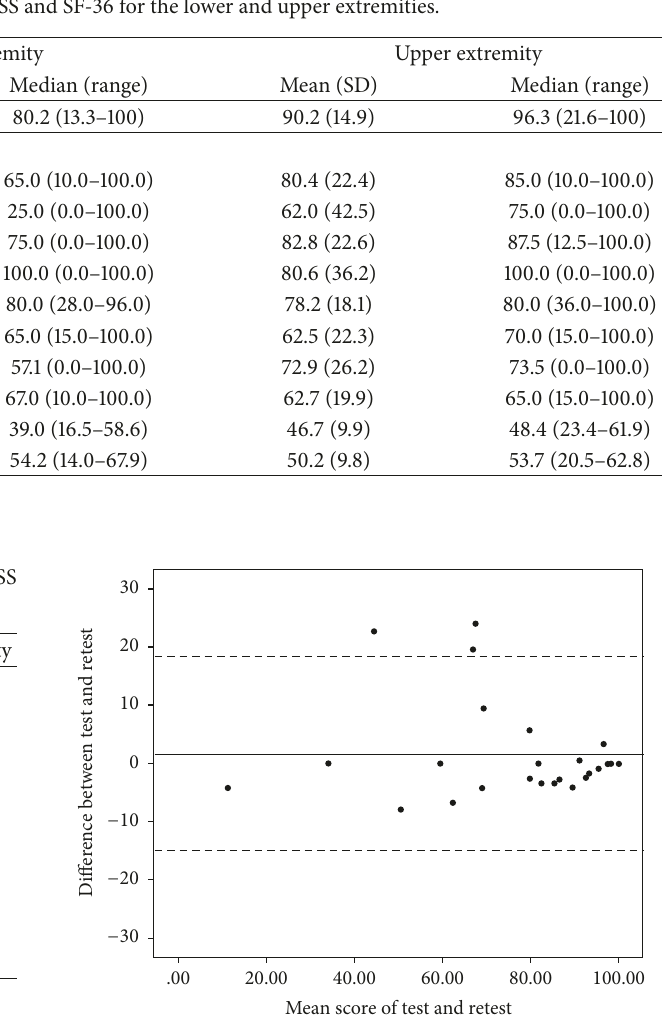
Figure2:Bland-Altmanplotofthetest-retestreliabilityoftheDutch TESS-LE. The solid line shows the mean difference of the two tests (1.65) and the dashed lines show the 95% limits of agreement ( − 15.11;